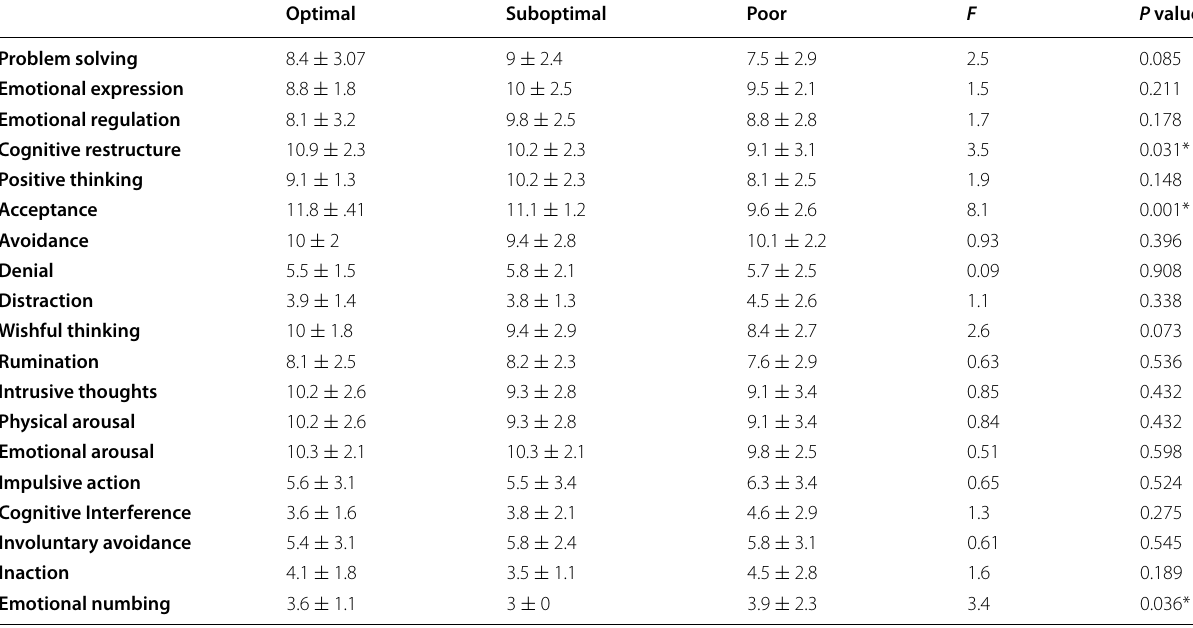
Table 4 Scores of coping strategies of the mothers and their relation with HbA1c levels of their diabetic children